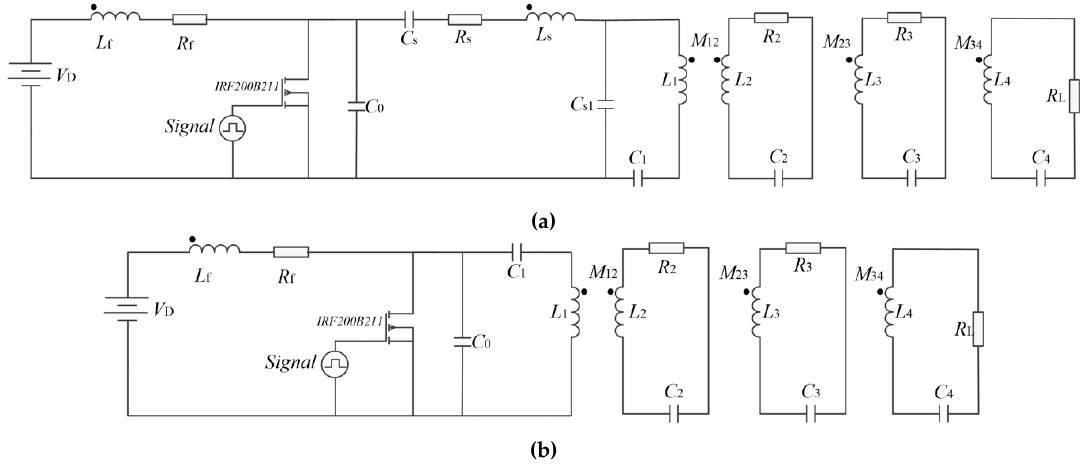
Figure 9. Circuits of ( a ) the traditional four-coil WPT system and ( b ) the proposed WPT system. Table 6. Performance comparison of two types of WPT systems.